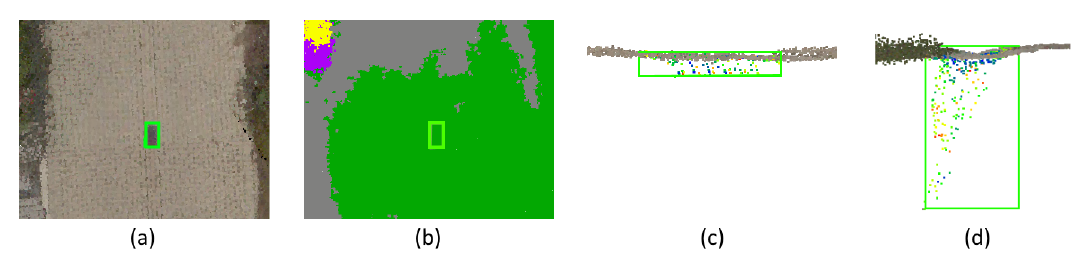
Figure 9. Example of undetected storm drain because of incorrect semantic segmentation of the RandLa-Net. (a) shows the point with RGB colours and the ground truth bounding box of the storm drain in green. (b) shows the semantic segmentation results where the storm drain section is segmented as grass instead of hardscape. (c) and (d) show the difference in cluster size under the road surface between an undetected and detected storm drain respectively. Storm drain points are coloured based on intensity